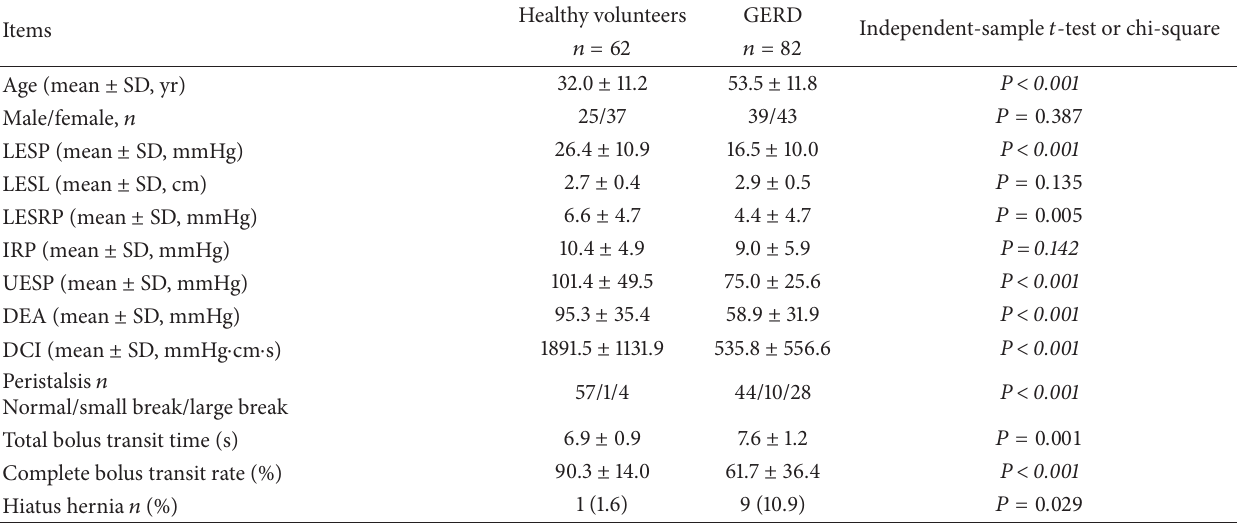
Table 2: Demographic data and high-resolution manometry and impedance results of different Chinese groups.